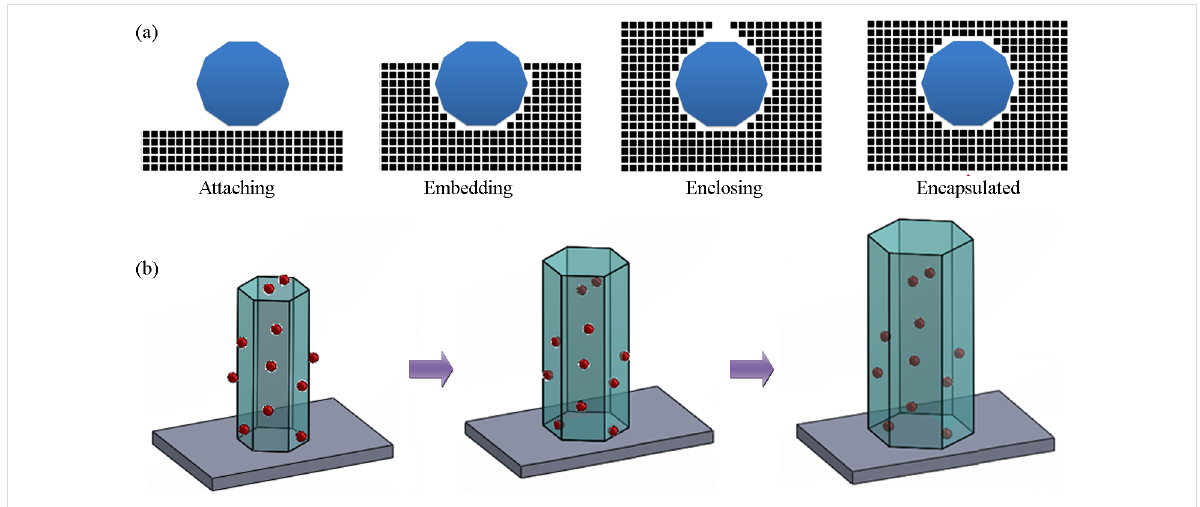
Figure 5: (a) Illustration of the encapsulation process of a surface-attached nanoparticle into the growing crystal. (b) Encapsulation of nanoparticles into a ZnO nanorod by regrowing the